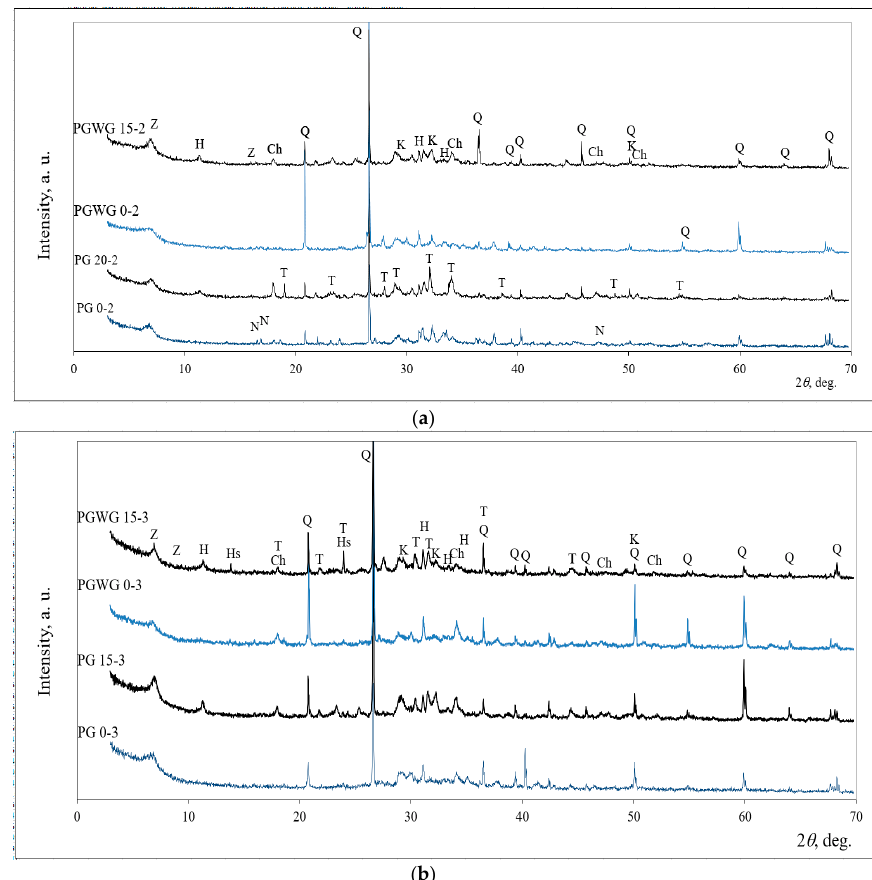
Figure 5. X-ray diffraction patterns of alkali activated biomass bottom ash when SiO 2 /Na 2 O molar ratio is ( a ) 2 and ( b ) 3. Notes: Q—quartz, SiO 2 (83–2465); Ch—calcium hydroxide, Ca(OH) 2 (84–1268); K—calcium silicate hydrate, Ca 1.5 SiO 3.5 x H 2 O (33–306); T—thenardite Na 2 SO 4 (74–2036); Z—sodium aluminum silicate hydrate Na 96 Al 96 Si 96 O 384 216H 2 O (39–222); N—sodium carbonate hydrate Na 2 CO 3 (H 2 O) (70–845); Hs—hydroxy–sodalite Na 6 (AlSiO 4 ) 6 8H 2 O (72–2329); H—alcium aluminum hydroxide hydrate Ca 2 Al(OH) 7 · 3H 2 O